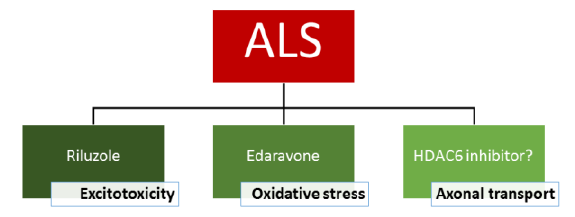
FIGURE 2: Treatment options for